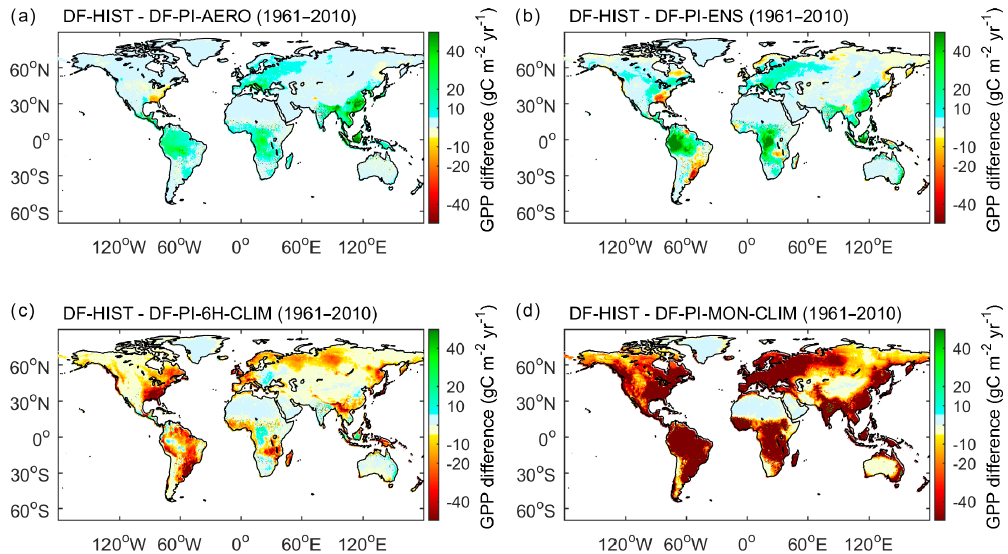
Figure 3. Spatial patterns of (cid:49) GPP (in gCm − 2 yr − 1 ) between DF-HIST and (a) DF-PI-AERO, (b) DF-PI-ENS, (c) DF-PI-6H-CLIM and (d) DF-PI-MON-CLIM during